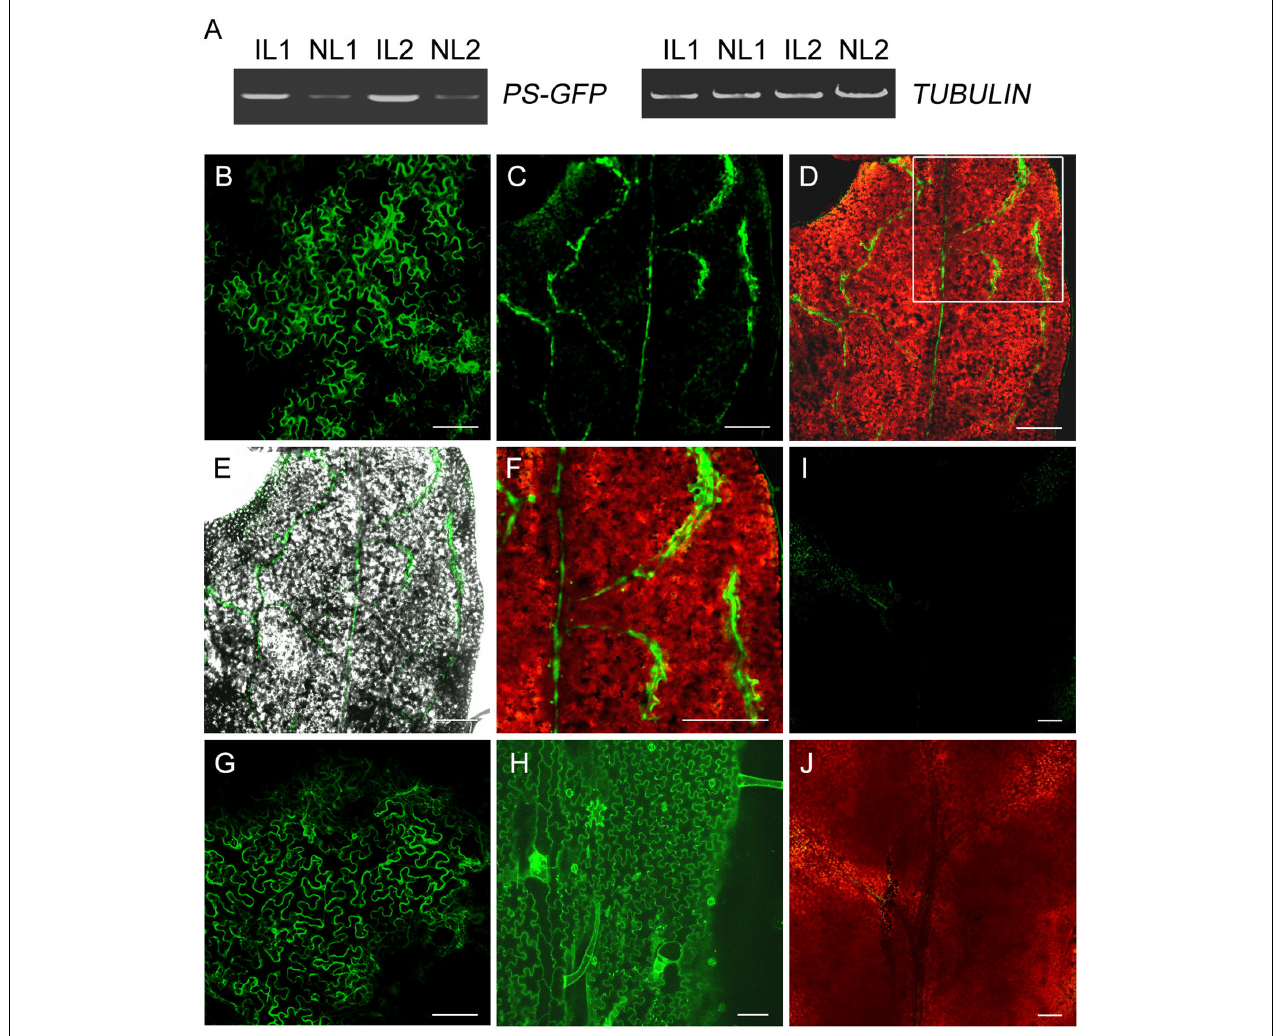
FIGURE 4 | Expression of GFP fusion protein in leaves of N. benthamiana . (A) RT-PCR analysis of levels of PS-GFP transcripts in infiltrated and non-infiltrated leaves of N. benthamiana. IL, infiltrated leaves; NL, non-infiltrated leaves. (B,G) Fluorescence signals in leaves infiltrated with Agrobacteria carrying pro35S::PS-GFP (B) or pro35S::GFP (G) construct. (C–F) Confocal microscopy demonstrated that PS-/SYS-GFP protein was primarily detectable the veins of non-infiltrated developing leaf of N. benthamiana whose lower leaves were infiltrated with Agrobacteria harboring pro35S::PS-GFP plasmid. Merged image of GFP fusion protein (green) and chloroplast autofluorescence (red) or the corresponding bright-field image is shown in D and E , respectively. Enlarged view of the veins of non-infiltrated leaf of the inset in D is shown in F . (H) Fluorescence signals in non-infiltrated leaf of N. benthamiana whose lower leaves were infiltrated with Agrobacteria harboring pro35S::GFP plasmid. Note that free GFP fluorescence was distributed evenly on the cell surface of leaf pavement cells. (I,J) Control image of non-transgenic leaf of N. benthamiana taken at the same laser intensity and exposure time as that in B–H . Scale bars: 100 µ m in B and G–J , 200 µ m in C–F